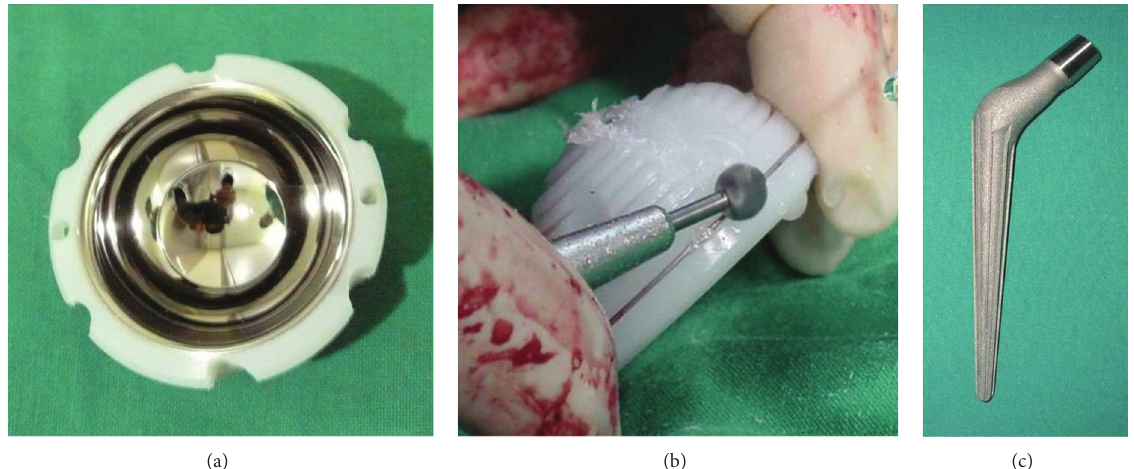
Figure 2: (a) and (b) The back surface of metal inlay polyethylene liner was downsized and roughened in a spider web manner with an electrical burr. (c) Fully coated, porous cone prosthesis with 8 ribs for rotational stability.